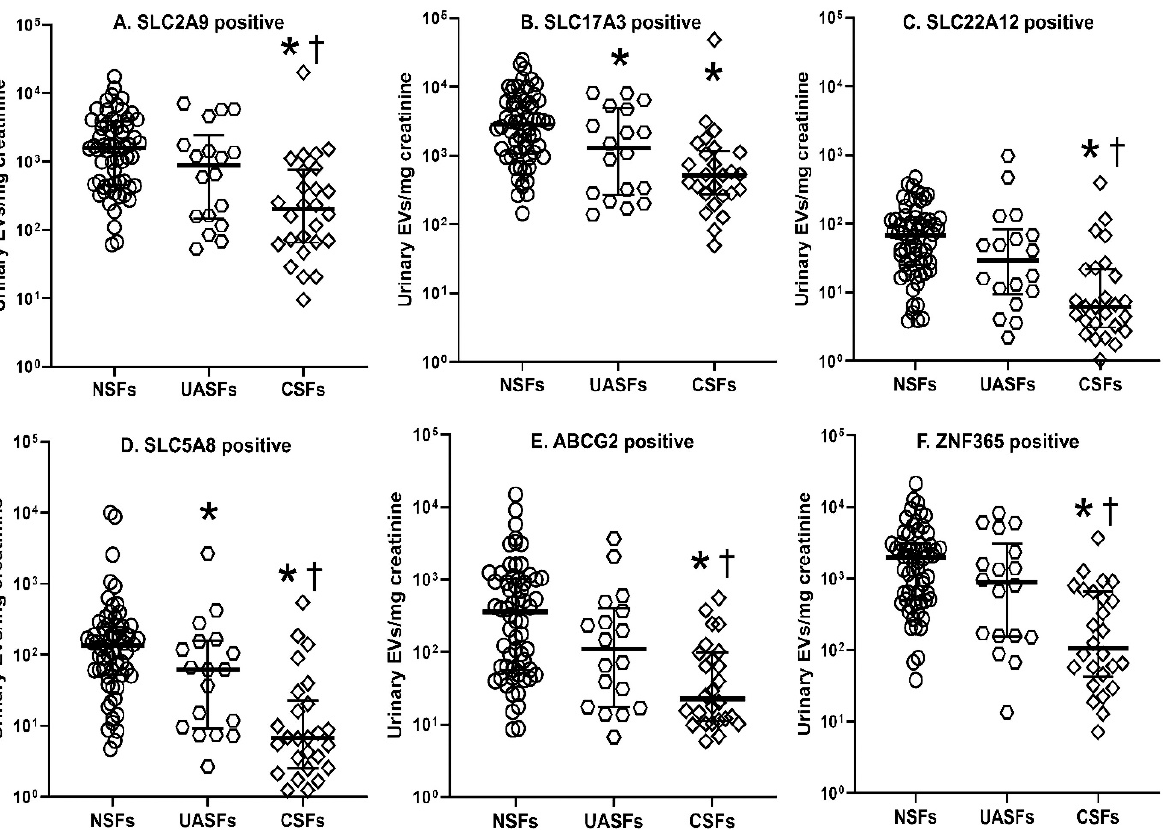
Figure 3. Urinary extracellular vesicles (EVs; microvesicles and exosomes) bearing six uric acid (UA)-transporters from UA stone formers (UASFs) and calcium stone formers (CSFs) and age-/sex- matched non-stone formers (NSFs). Urinary EVs were presented as the log 10 of EVs/mg creatinine. * p < 0.05 UASFs or CSFs vs. NSFs; † p < 0.05 UASFs vs. CSFs (Wilcoxon rank sum test). The concentrations of SLC2A9, SLC17A3, and ZNF365-bearing EVs were greater than SLC22A12, SLC5A8, and ABCG2-expressing EVs in human urine. Table 2. Twenty-four-hour excretion of u rinary extracellular vesicles (EVs; microvesicles and exosomes) bearing six uric acid (UA)-transporters from UA stone formers (UASFs) and calcium stone formers (CSFs) and age-/sex-matched non-stone formers (NSFs). Uric Acid Transporter-Positive EVs Excreted (10 6 per 24 h)